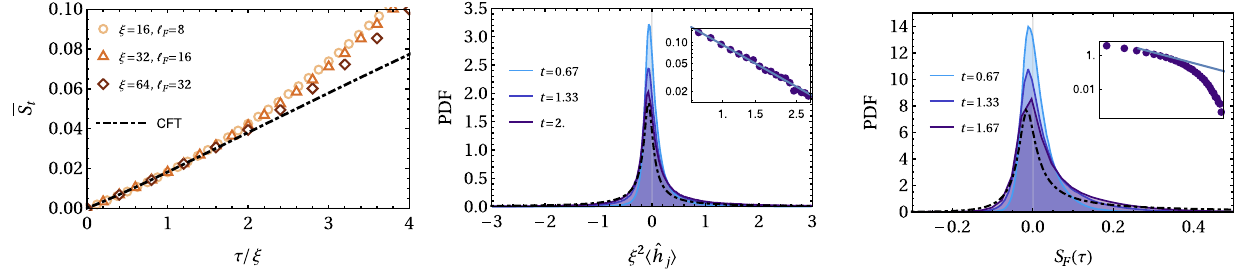
FIG. 3. Left: noise-averaged von Neumann entanglement entropy production S ð 1 Þ ð τ Þ vs t ¼ τ = ξ evolving in time under Eq. (44), for = ξ ¼ l ¼ 1 = 2 . The dotted line is obtained from the numerical solution of Eqs. (16) and using increasing values of ξ and fixed ratio l F τ Þ ¼ c ¯ κ = 6 with c ¼ 1 . Middle: distribution of the scaled energy density ξ 2 h ˆ h τ Þi at ξ ¼ 64 . For the Eq. (34) for n → 1 , i.e., S F ð i ð ˆ → h ð x; t Þ and at large time h ð x; t Þ is distributed as Eq. (5), which in h analytical prediction, we use that in the scaling limit ξ 2 h j i the present case reduces to h ¼ in law ð 3 Ω − 5 Þ = ð 24 π Þ . In the inset, the right tail of the distribution is shown in log-log scale, showing the τ Þ at ξ ¼ 64 for an interval of size l 32 . For the analytical predicted ∝ h − 3 = 2 tail. Right: distribution of the entanglement entropy S F ð F ¼ τ Þ ¼ in law c ð κ þ þ κ − Þ = 12 , with κ (cid:3) independently distributed according to P κ Þ . prediction, we use that in the stationary limit lim τ → ∞ S F ð stat ð κ Þ is obtained by numerically inverting the Fourier transform Q 1 Þ as a function of k , for l ¼ 1 = 2 , The stationary distribution P k ð stat ð defined in Eqs. (E9) and (E39) in Appendix E. All simulations are performed on systems of total length L ¼ 2048 and are repeated for 800 N sample ¼